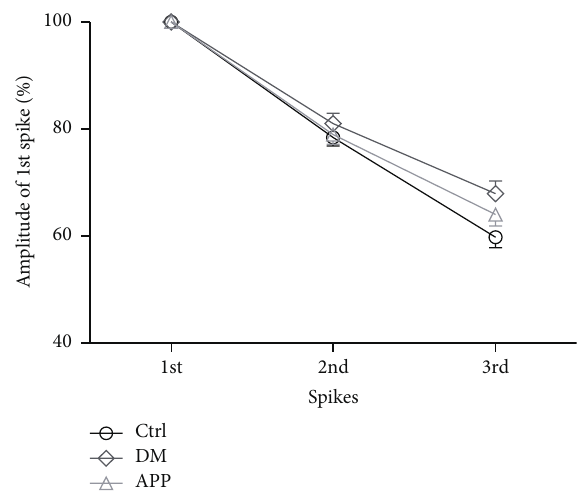
Figure 5: Comparison of intraburst amplitude attenuation between the three groups. Amplitude attenuation within bursts was reduced in diabetic rats ( 𝑛 = 26 ) either for the 2nd/1st spike ( 𝑃 < 0.001 , Mann-Whitney test) or for the 3rd/1st spike ( 𝑃 < 0.001 , Mann- Whitney test). Treatment of APP 17-mer peptide partially reversed the decrease in amplitude attenuation ( 𝑛 = 35 , 𝑃 < 0.001 , Mann- Whitneytest,forthesecondspike; 𝑃 < 0.001 forthethirdspike).The difference in amplitude attenuation between APP and Ctrl group ( 𝑛 = 59 ) only was significant at the third spike ( 𝑃 < 0.001 , Mann- Whitney test). For the second spike, no difference was observed ( 𝑃 = 0.314 , Mann-Whitney test). “ 𝑛 ” represents number of